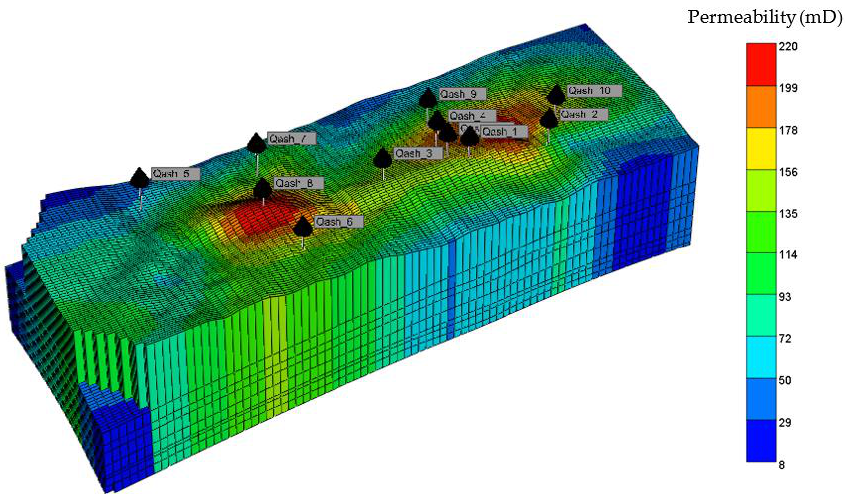
Figure 6. Kashkari oil field 3D model showing distribution of permeability.